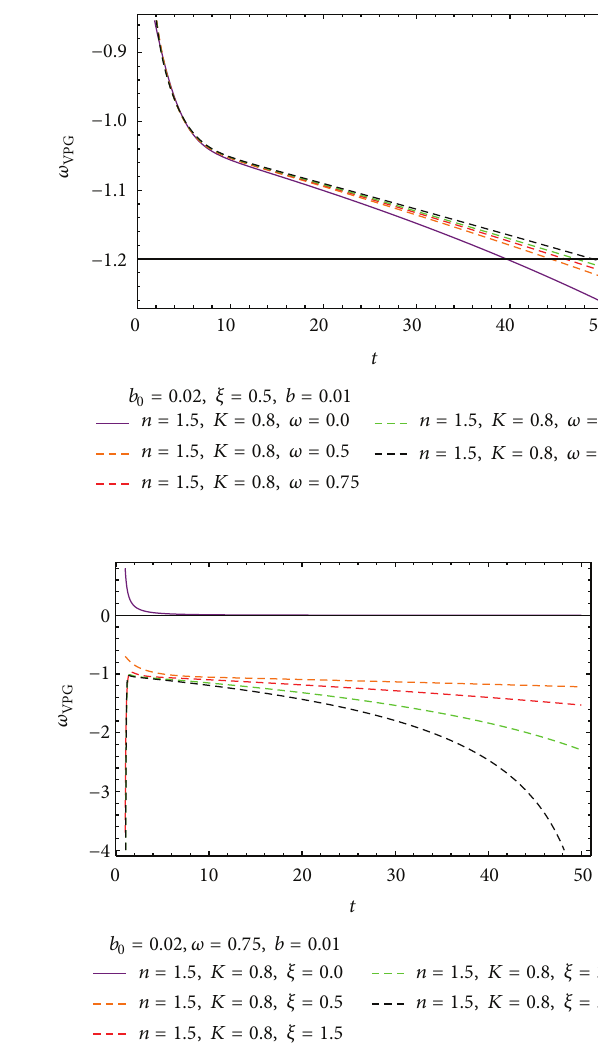
against 𝑡 for interacting barotropic fluid and viscous polytropic gas. VCG